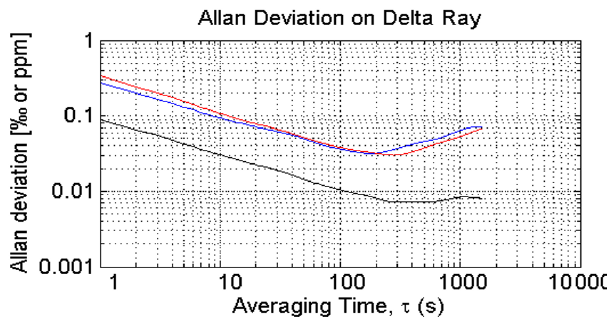
Figure 3. Allan deviation determined in QC-1: blue is δ 13 C, red is δ 18 O and black is CO 2 , determined during the 2015